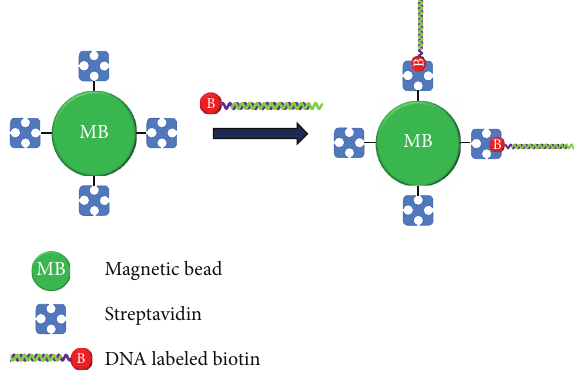
Figure 12: Application of the polystyrene-coated fluoromicrobeads for the detection of cTnI on the protein microarray (adapted from [37]).